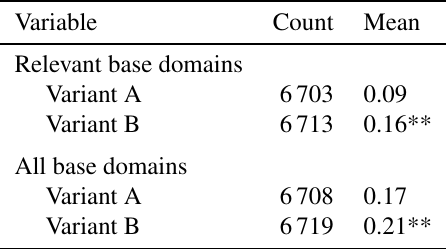
Table 3. Average decrease of domains with below peer score baseline. The decrease is higher for the new governing method, indicating on average fewer domains have scores below a peer score